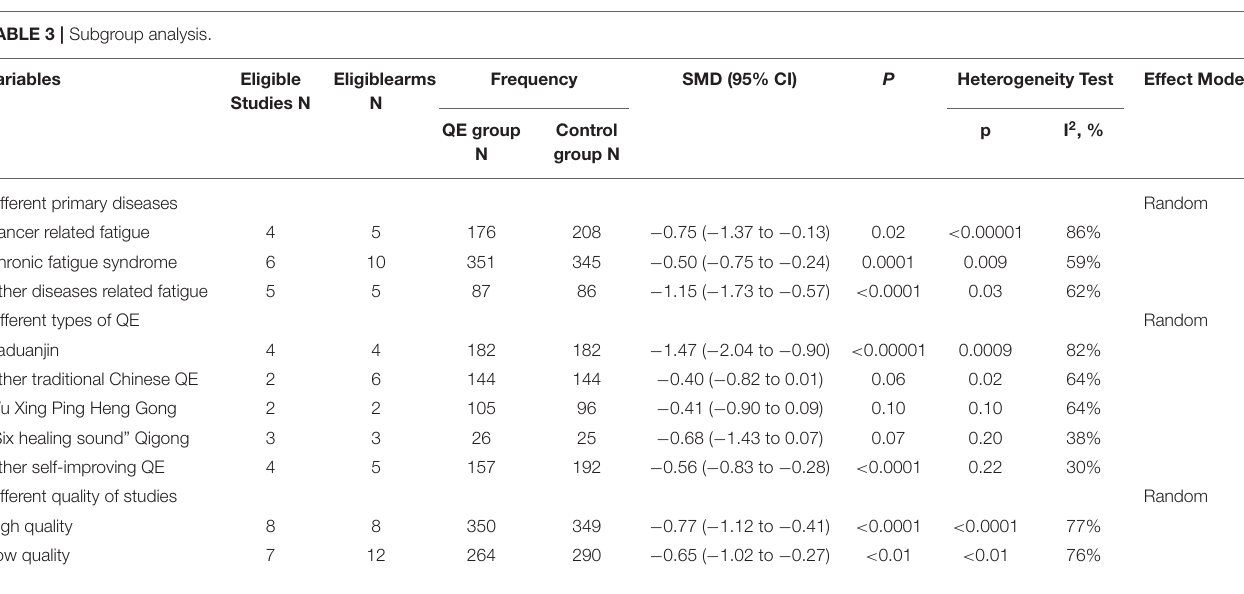
TABLE 3 | Subgroup